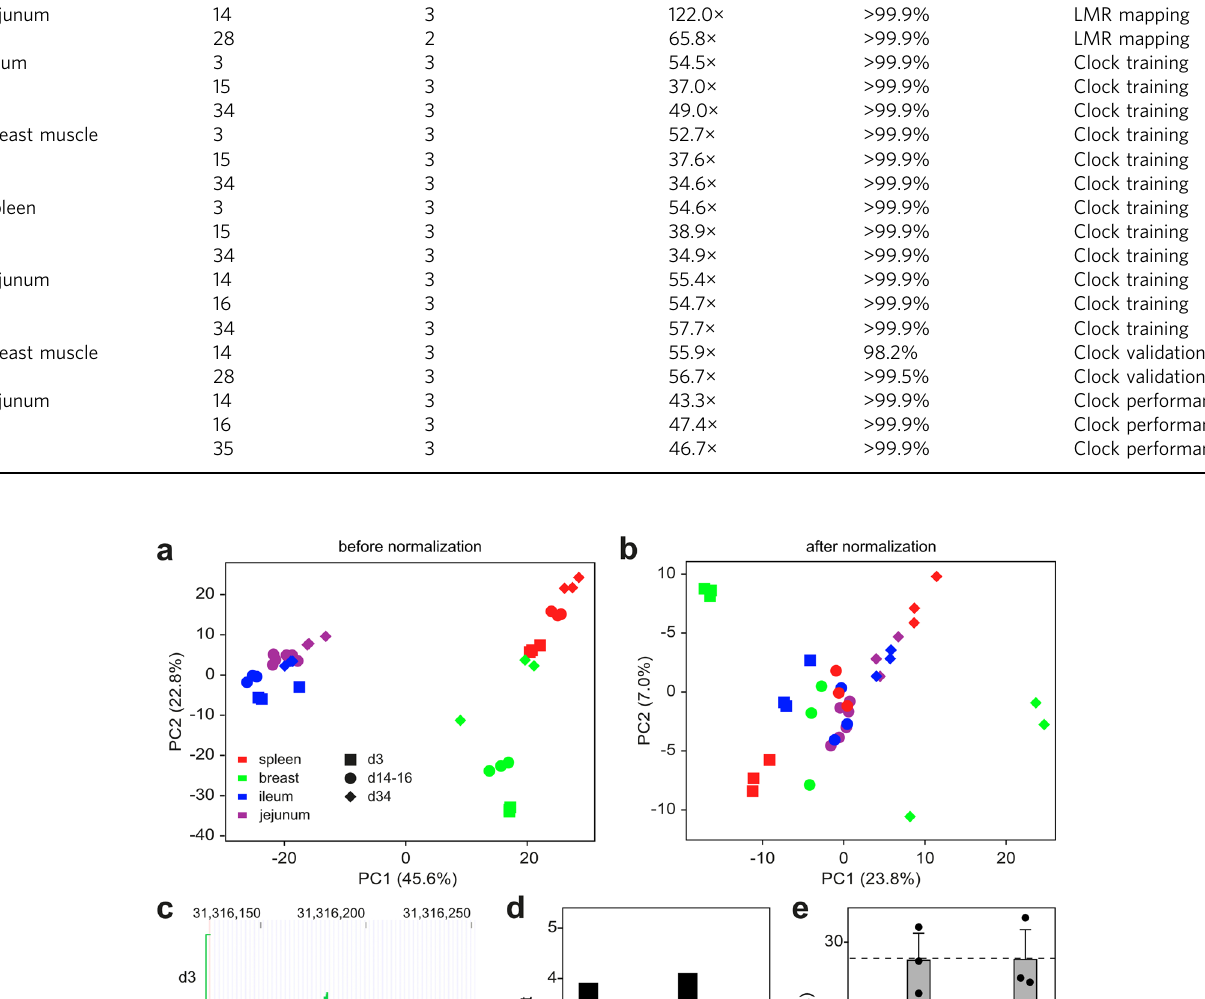
Table 1 Whole-genome bisul fi te sequencing datasets generated in this study. Tissue Age (days) No. of samples